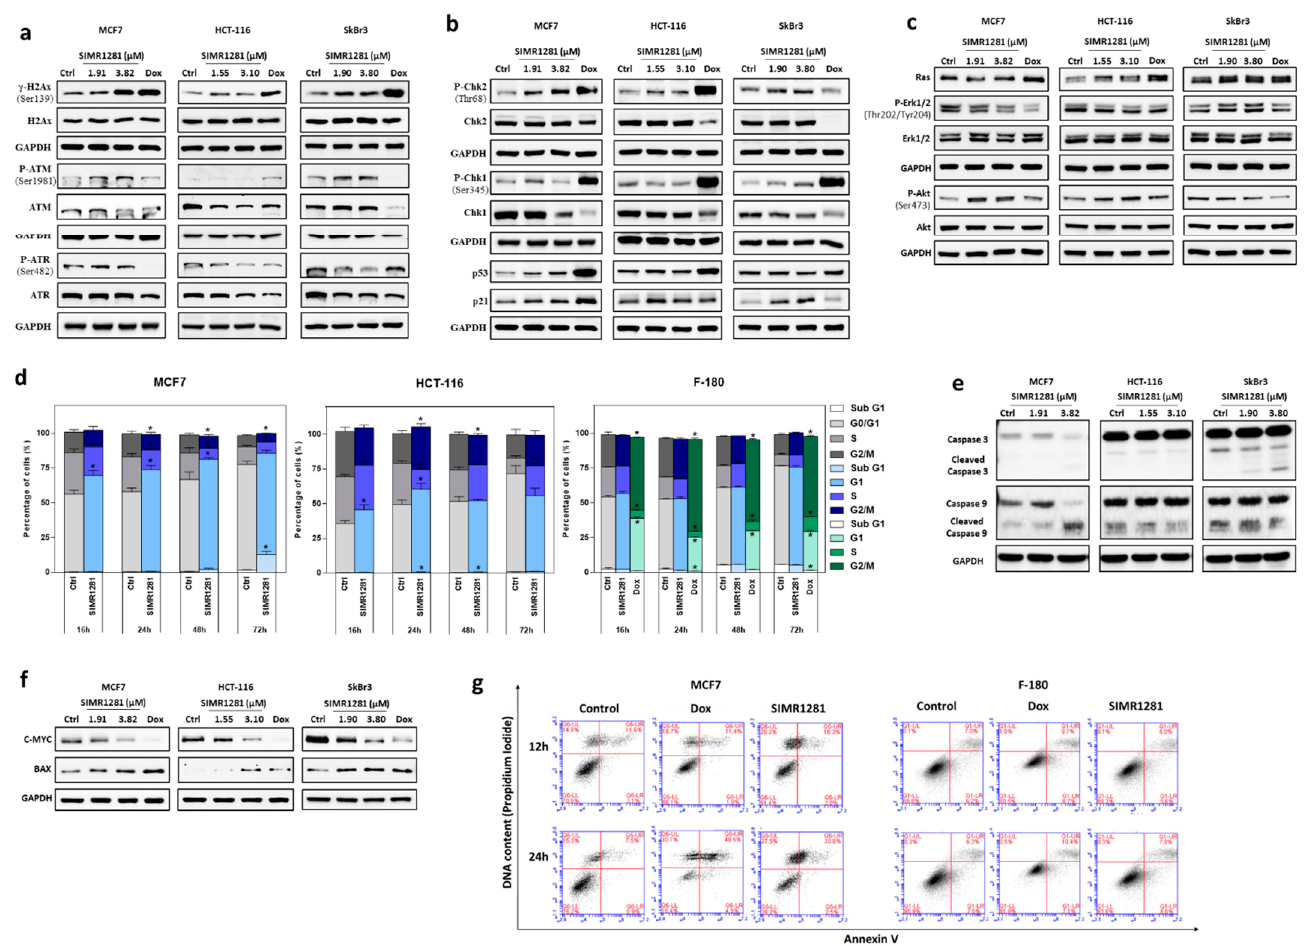
Figure 3. SIMR1281 possesses a potent pleiotropic anticancer effect. ( a – c ) Western blot analysis of the expression levels of the indicated proteins following treatment with SIMR1281 in MCF7, HCT-116, and SkBr3 cells ( n = 3). ( d ) Cell cycle arresting potentials of SIMR1281 in the treated MCF7, HCT-116 and F-180 cells ( n = 3). * Indicates significant difference versus control at p < 0.05 (*) by two-tailed unpaired t -test. ( e , f ) Immunoblots of the indicated proteins following treatment with SIMR1281 in MCF7, HCT-116, and SkBr3 cells ( n = 3). ( g ) Annexin V/PI staining of MCF7 and F-180 cells after treatment with Dox and SIMR1281 ( n = 3). Full Western blots are available in Figures S3–S5,S7,S8.